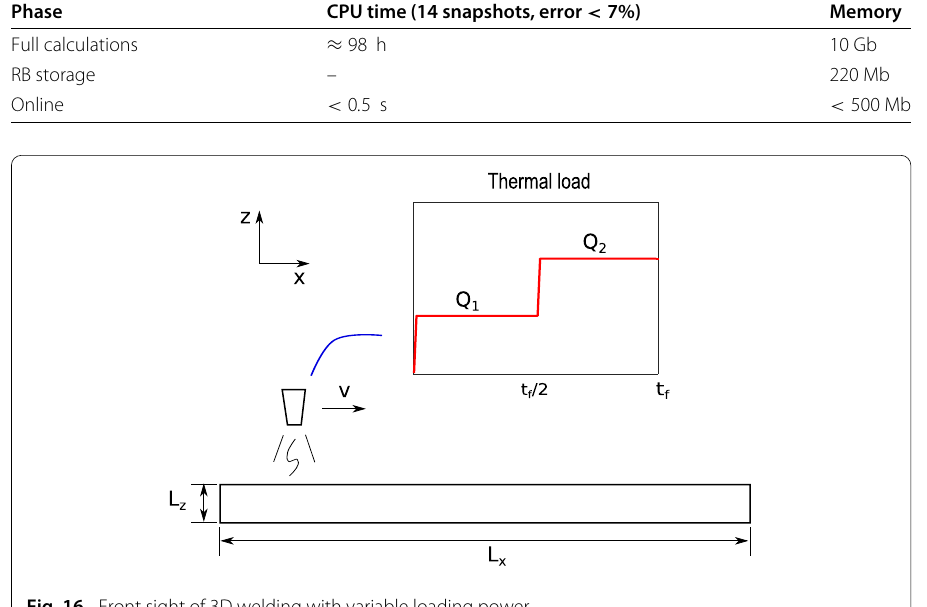
Fig. 16 Front sight of 3D welding with variable loading power Computational vademecum for real-time process control of welding